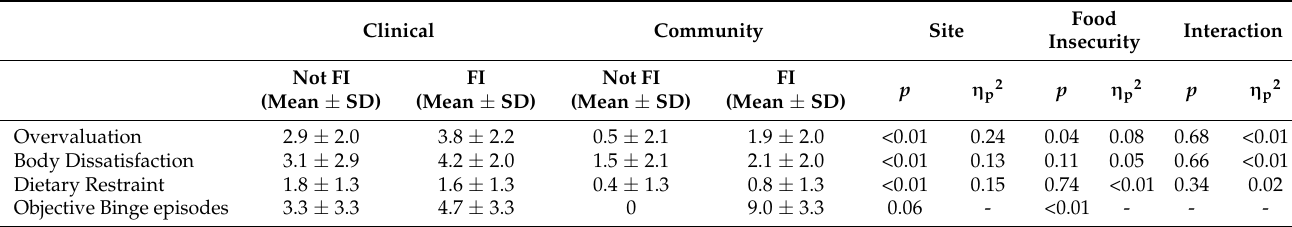
1 Abbreviations: Not FI = not food insecure, FI = food insecure.